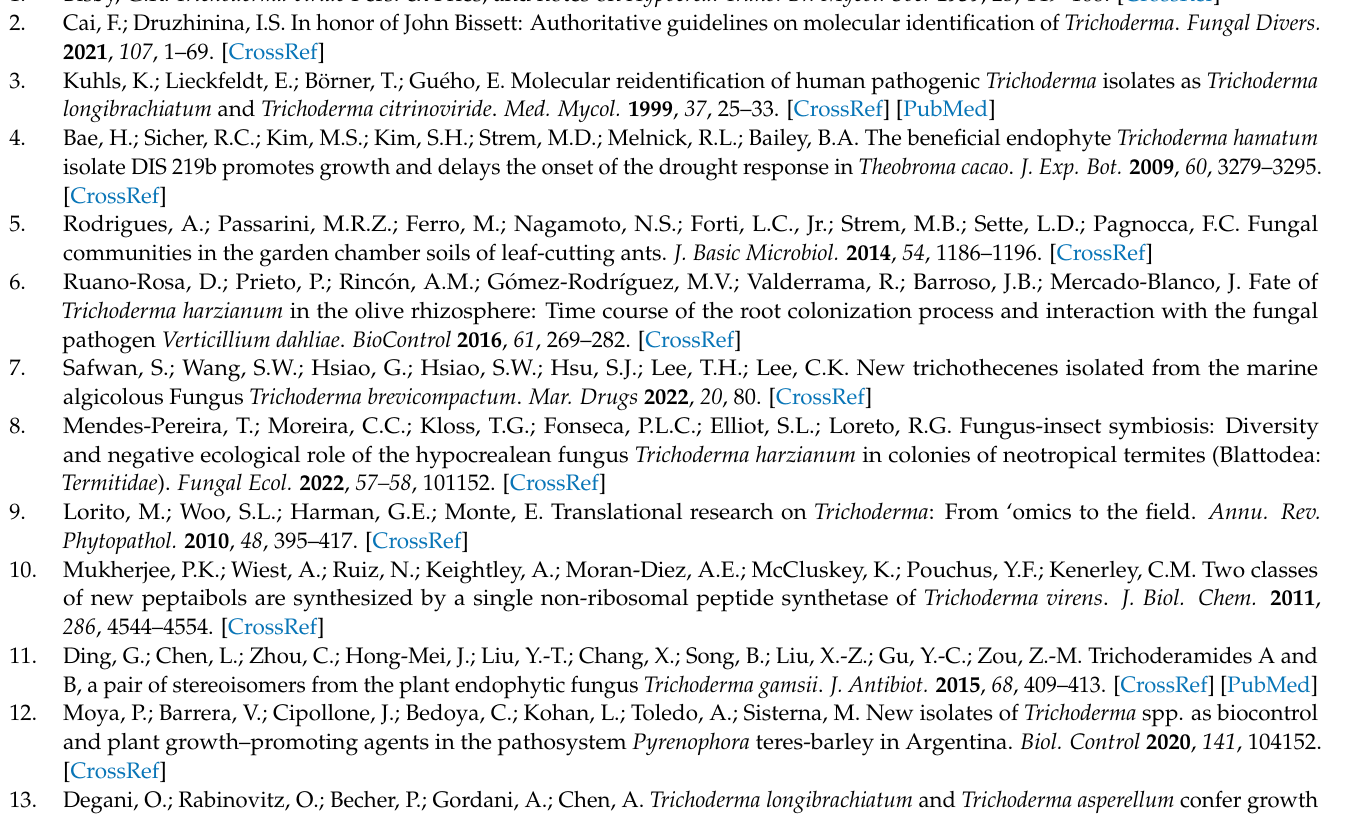
Figure S30: MS (A) and MS/MS (B) spectra of endophytin